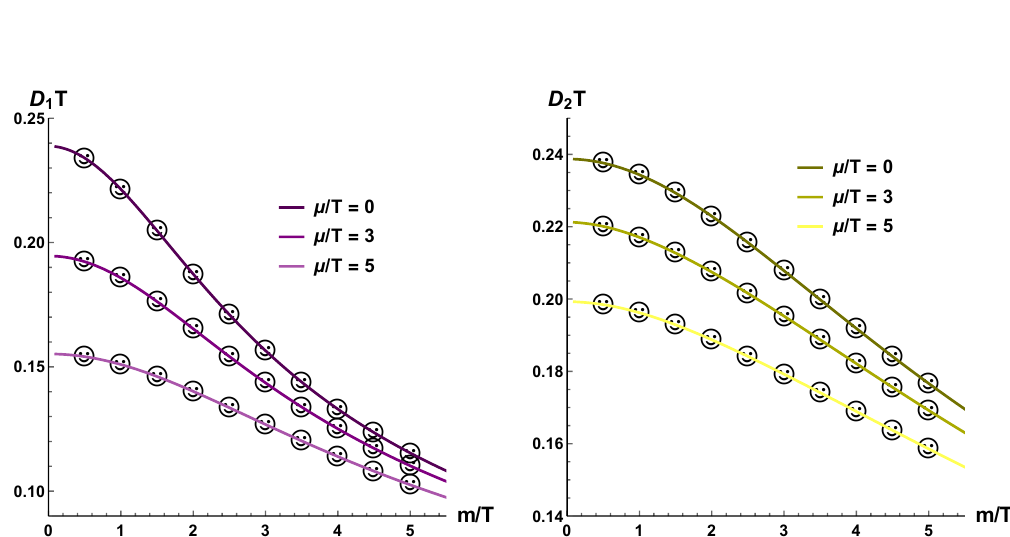
Figure 8 . The predictions from hydrodynamics for the benchmark potential V ( X ) = m 2 X 3 and various values of (cid:22)=T . The di(cid:11)usion constants are obtained by solving the coupled equation (4.5). Left: The di(cid:11)usion constant D 1 which in the limit (cid:22) ! 0 corresponds to the crystal di(cid:11)usion. Right: The di(cid:11)usion constant D 2 which in the limit (cid:22) ! 0 corresponds to the charge di(cid:11)usion.